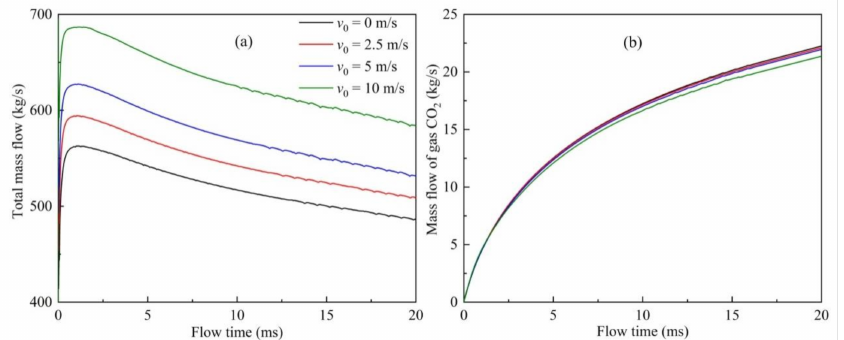
Figure 9. Effects of flow velocity on ( a ) total mass flow and ( b ) mass flow of gas CO 2 of rupture